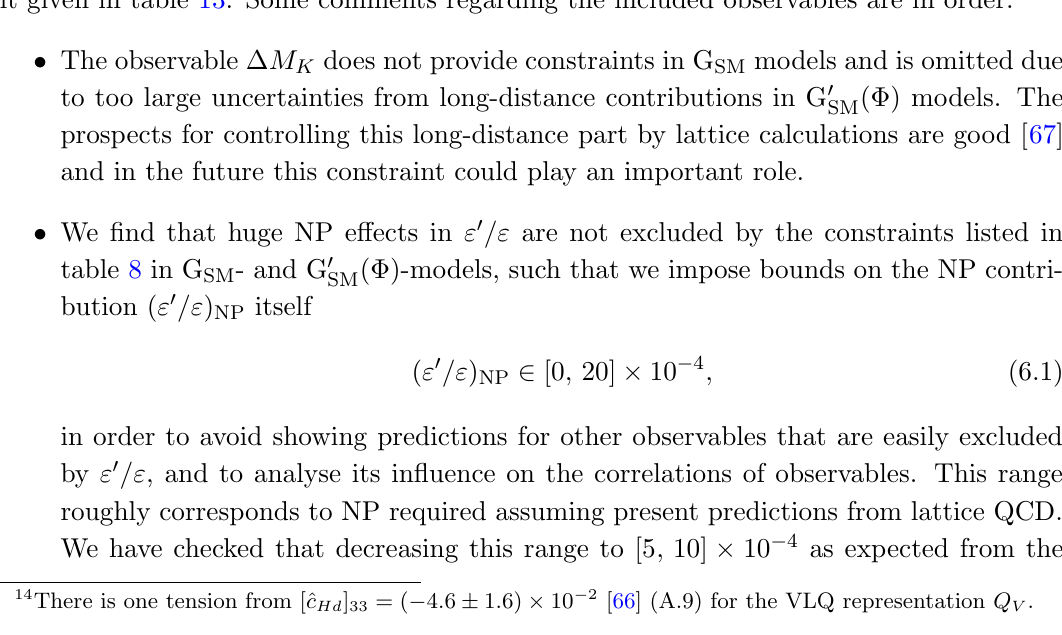
table 8. Master formulae used in these constraints are collected in appendix C. The SM predictions in table 8 are based on the determination of CKM parameters from a tree-level (cid:12)t given in table 13. Some comments regarding the included observables are in order: The observable (cid:1) M does not provide constraints in G models and is omitted due K SM (cid:15) to too large uncertainties from long-distance contributions in G 0 ((cid:8)) models. SM